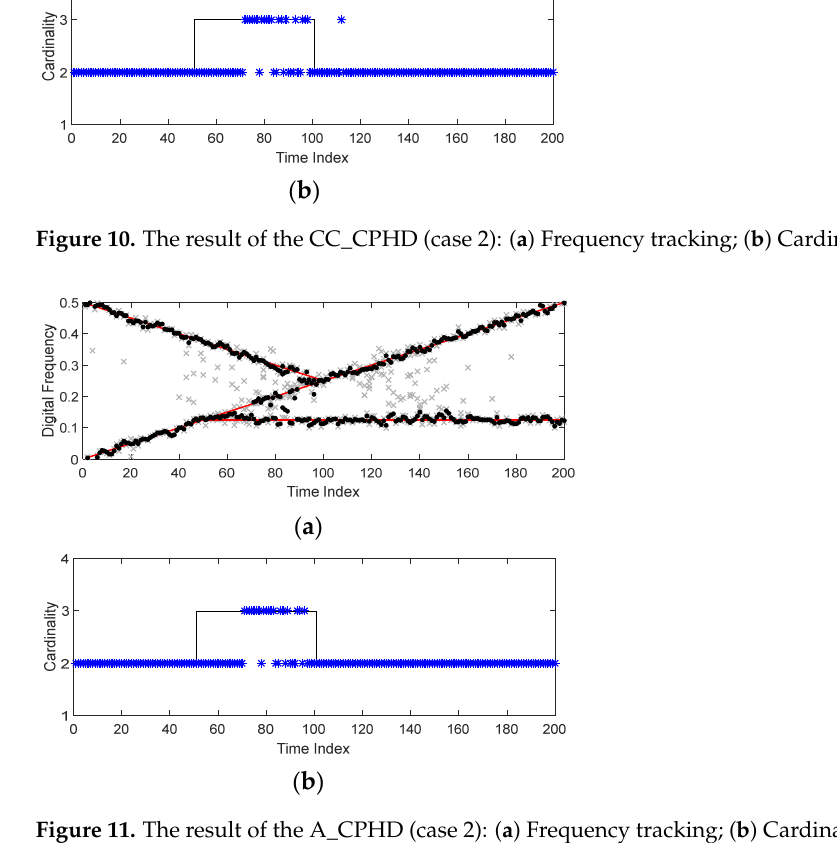
Figure 11. The result of the A_CPHD (case 2): ( a ) Frequency tracking; ( b ) Cardinality estimate.